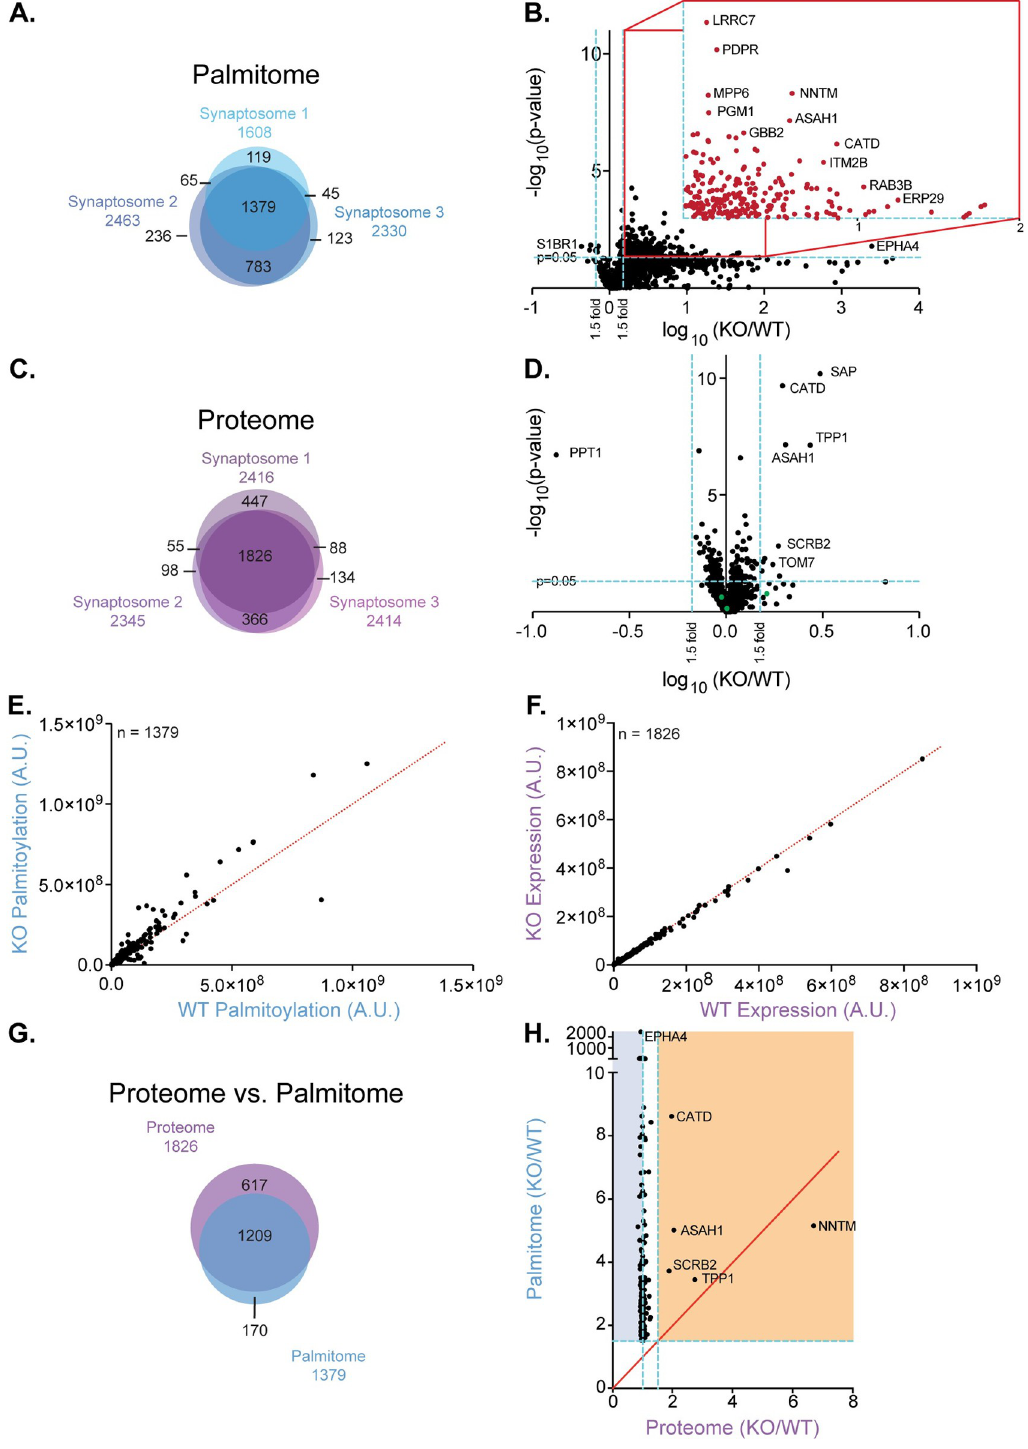
Fig 2. Putative PPT1 substrates are enriched at the synapse and display persistent palmitoylation. (A) Venn diagram of 3 palmitome experiments exhibits 1,379 common proteins. (B) Volcano plot indicates 242 proteins are significantly differentially palmitoylated (4 decrease; 238 increase; 1.5-fold, p < 0.05; blue lines; S2 Table, S1 Data ). Inset shows significantly increased proteins. The p -value was calculated using a 2-tailed t test on 3 biological and 3 technical replicates. While the technical replicates do not meet the t test condition for independence, we chose to proceed in this manner to generate more